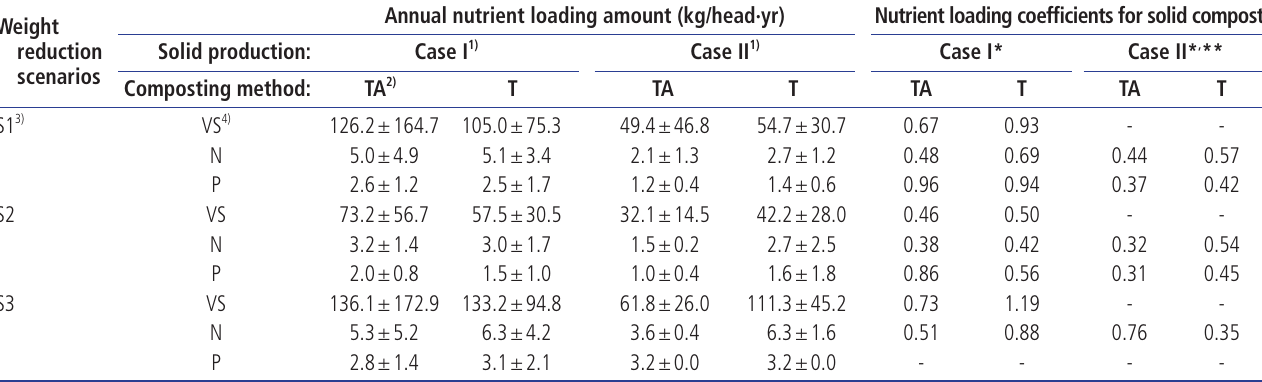
Table 6. Annual nutrient loading amount per head with combination constructed with nutrient loading coefficients for solid compost